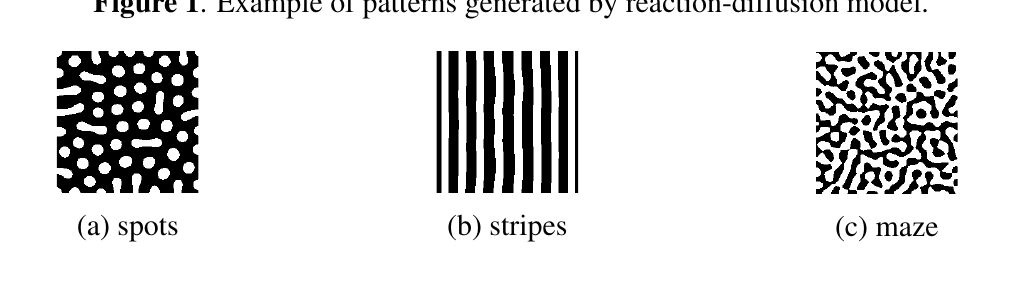
Figure 1 . Example of patterns generated by reaction-diffusion